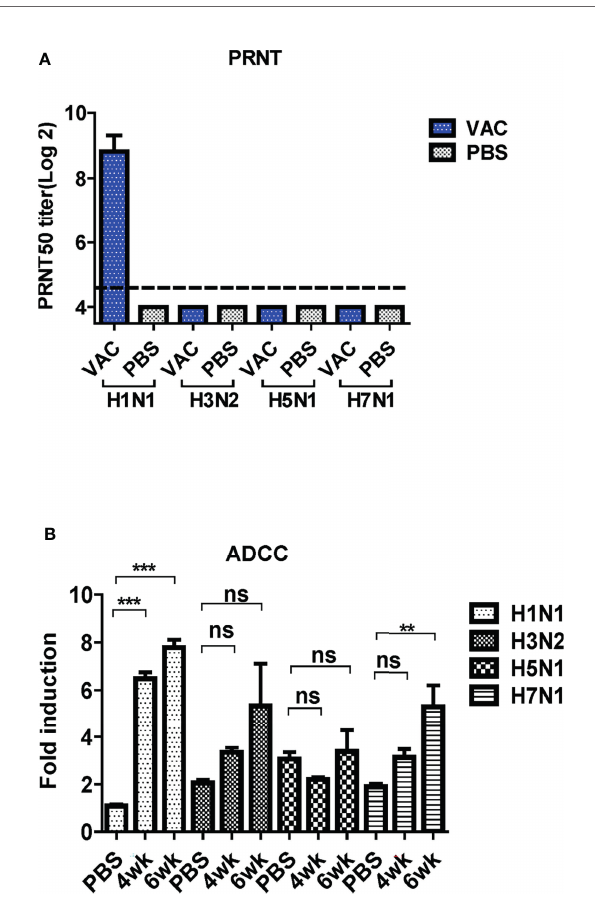
FIGURE 7 | Cross-protective mechanism of immune sera from mice. (A) Neutralizing activity of antibody-induced vaccination. Four types of viruses (H1N1, H3N2, H5N1, and H7N1) and mice sera collected 6 weeks post- vaccination were used for determining the neutralizing activity. The detection limit was indicated by a dotted line in the graph. The experiment was repeated twice with the pooled sera of each group (N=2) , and the error bar indicates the standard deviation (SD). (B) Antibody-dependent cellular cytotoxicity (ADCC) activity of mice sera. ADCC assay was performed by mFc g RIV ADCC reporter bioassay, and fold induction means the RLU (induced – background)/RLU (no Ab control – background). The graph shows the mean of each cohort (N=5) , and the error bar means the SD. One-way ANOVA test was performed for comparing the differences between sera from 4-week, 6-week, and PBS groups (***P < 0.001; **P < 0.01; ns means not signi fi